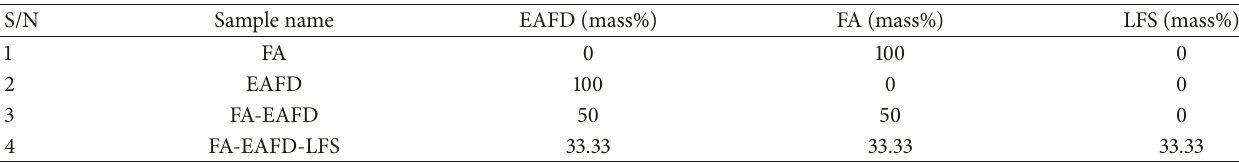
Table 1: The solid residue compositions of the